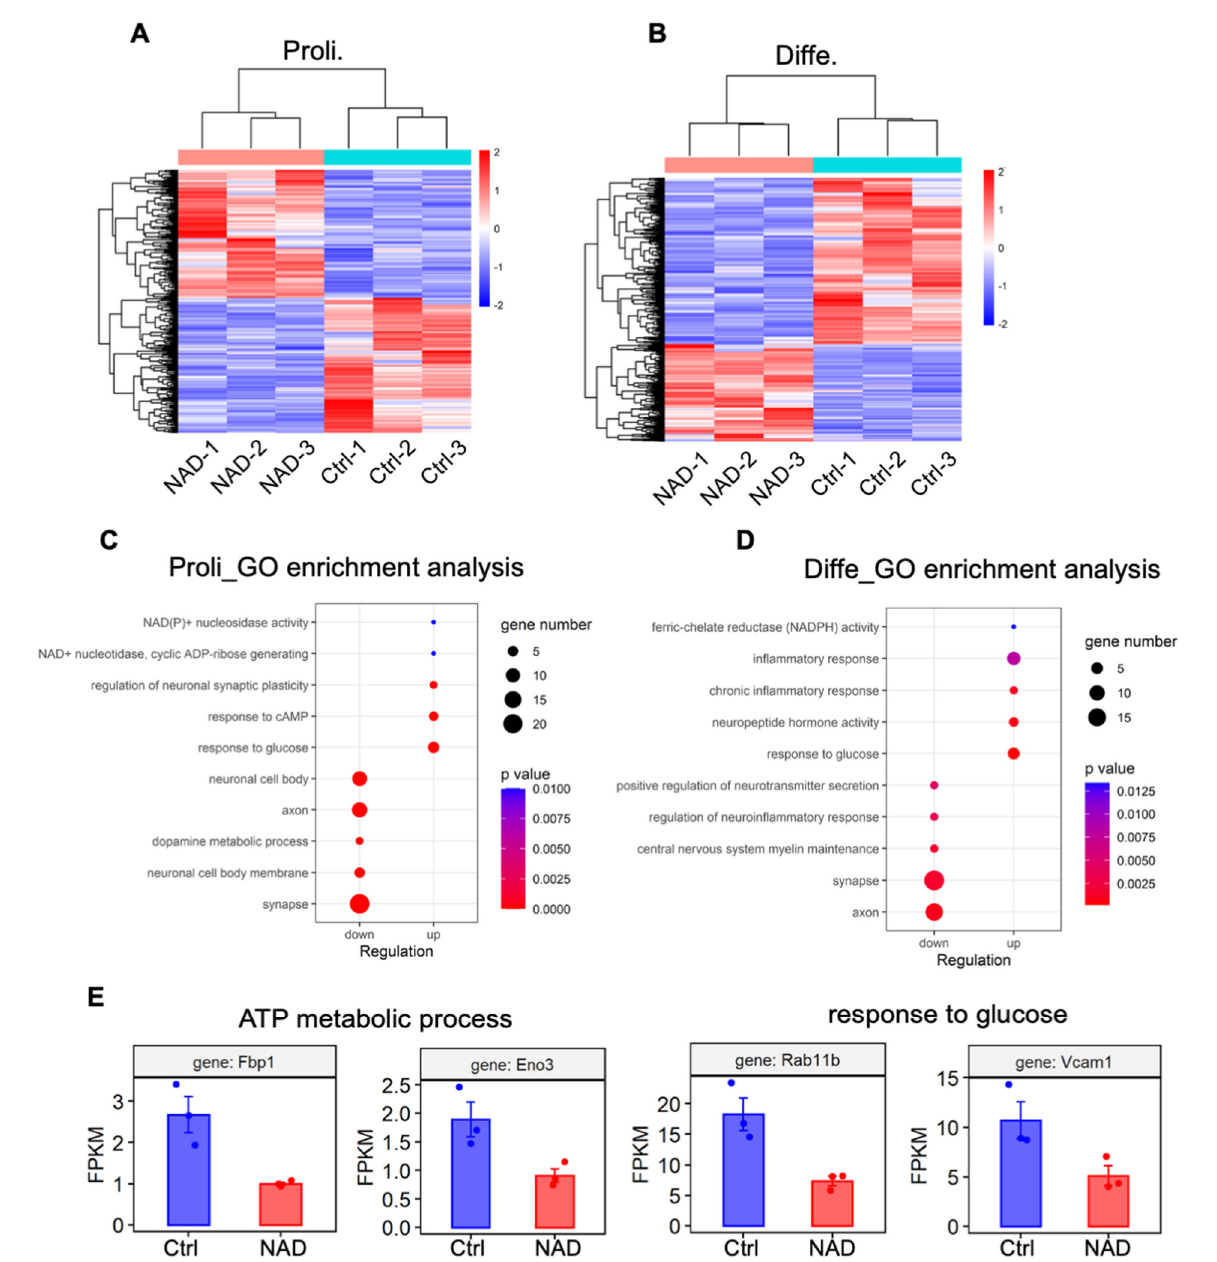
Figure 5. NAD+ exposure alters the transcriptome of aNSPCs under proliferating and differentiation conditions. ( A , B ) Heatmap showing the differentially expressed genes (DEGs) in Ctrl and NAD+ exposure groups under proliferating ( A ) and differentiation ( B ) conditions. Three biological repeating samples of Ctrl and NAD+ exposure (1 mM) were adopted for RNA sequencing. The significance of expression was determined by the |FC| > 2 and p -value < 0.05. ( C ) GO enrichment analysis of the up-regulated and down-regulated genes induced by NAD+ exposure (proliferating condition). The significance of expression was determined by |FC| > 2 and p -value < 0.05. ( D ) GO enrichment analysis of the up-regulated and down-regulated genes induced by NAD+ exposure (differentiation condition). The significance of expression was determined by |FC| > 2 and p -value < 0.05. ( E ) FPKM values of several genes related to ATP metabolic process and response to glucose.